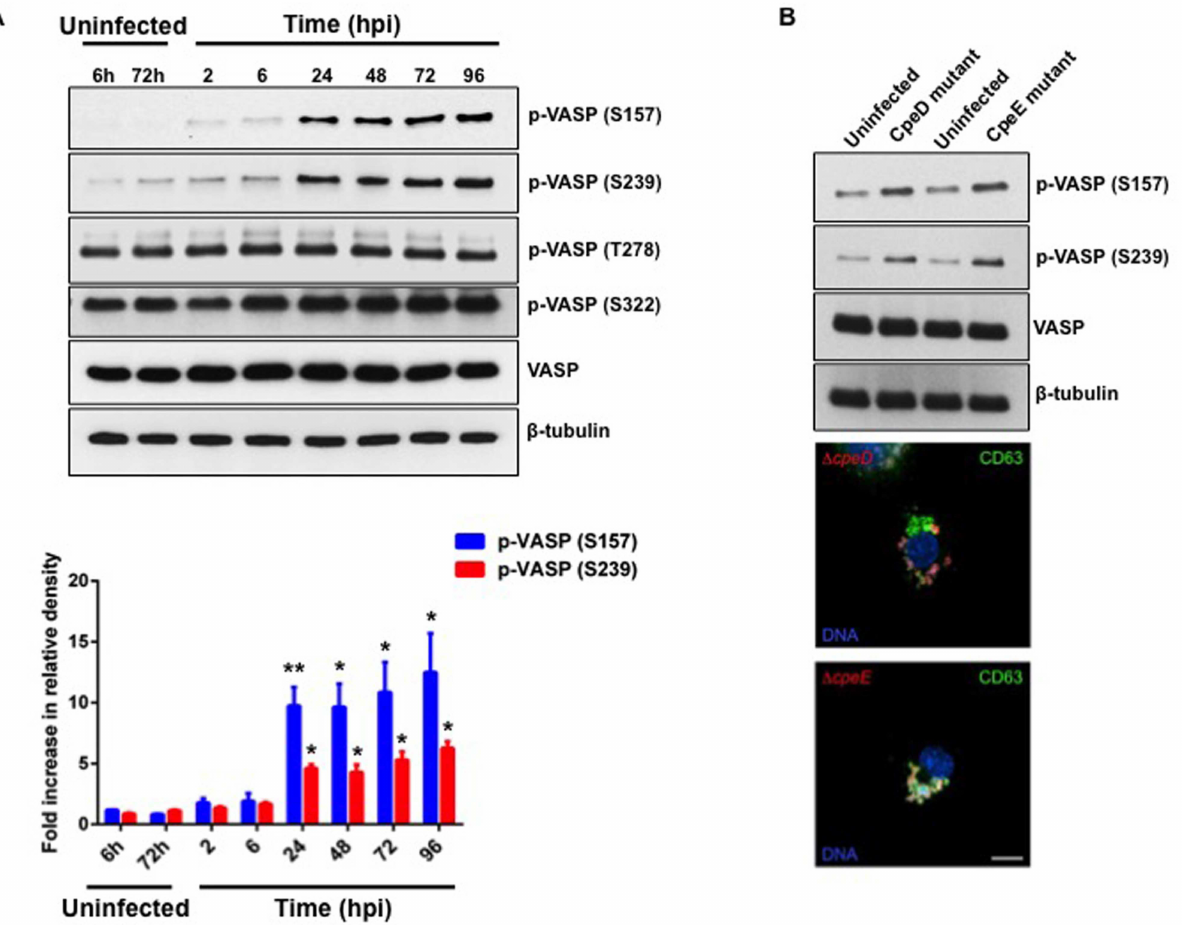
Fig 2. VASP phosphorylation levels increase during C . burnetii intracellular growth. (A) THP-1 cells were infected with C . burnetii for the indicatedtimes and uninfected cells at 6 and 72 h were harvested as controls. (B) THP-1 cells were infected with C . burnetii deficient in CpeD or CpeE and harvestedat 72 hpi for immunoblot or immunofluorescence analysis. Cell lysates were subjected to immunoblot analysis using antibodiesdirected against phosphorylated (S157, S239, S322, or T278) or total VASP. β -tubulin served as a loading control. Densitometric analysisis shown in the graph and represents an average of three independent experiments. Band intensities for all experimental conditionswere normalizedto β -tubulin levels, then compared to the averageof uninfected controls. Error bars indicate the standard error of the mean. ** indicatesp < 0.005 and * indicatesp < 0.05 accordingto a Student’s t test. In panel B, cells were processed for microscopy using antibodies directed against C . burnetii (red) and CD63 (green). DAPI was used to stain DNA (blue). Levels of phosphorylated VASP (S157 and S239) increase significantly from 24–96 hpi by wild type and CpeD- (top) or CpeE-deficient (bottom) mutants that form a small, atypical PV, indicatingthat an expandedPV is not requiredfor VASP